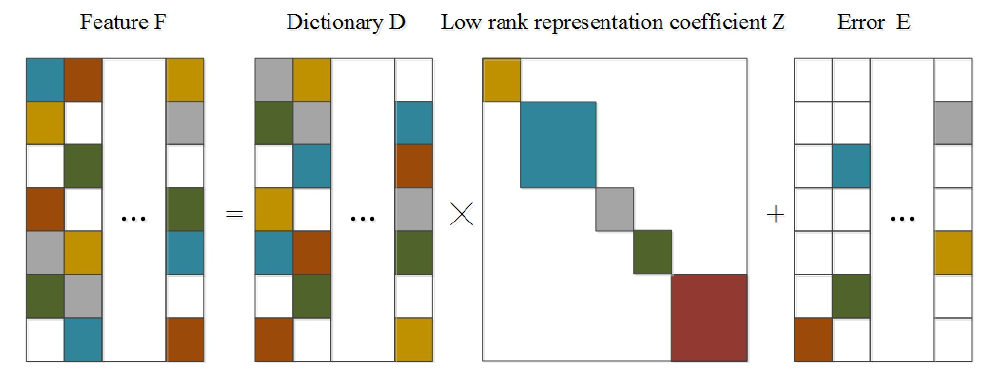
Figure 6. The representation with diagonal-block structure.